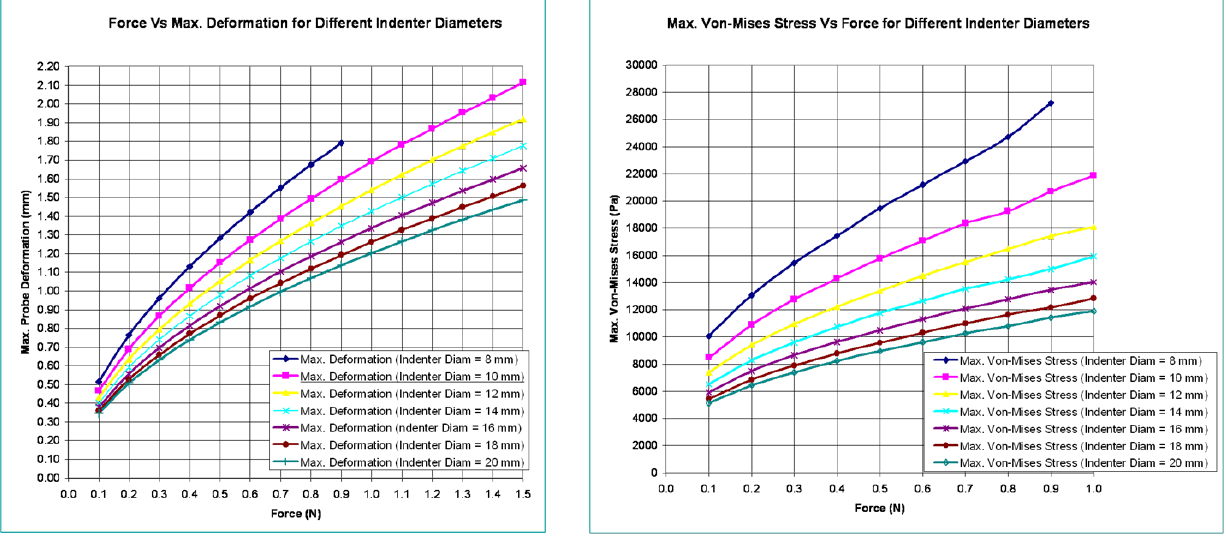
Figure 6. Deformation and Von-Mises stress variation for different indenter diameters and applied normal forces.